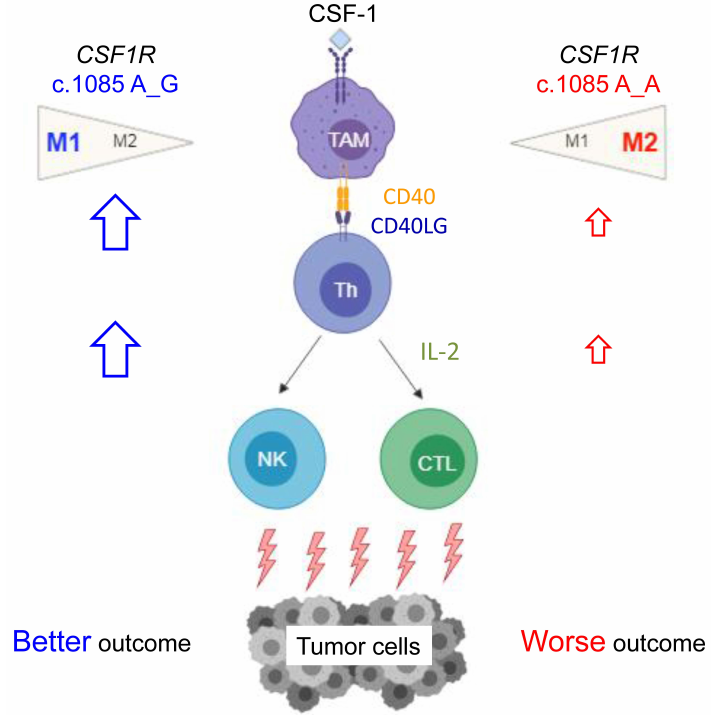
Figure 5. CSF1R c.1085 genotype regulated tumor immunity and affected clinical outcome. Macrophages with different CSF1R c.1085 genotypes responded to the stimulation of CSF-1 differen- tially. CSF-1 induced a prominent activation of CSF-1R, leading to an M2-like dominant polarization in macrophages with CSF1R c.1085 genotype A_A. CRC patients with CSF1R c.1085 genotype A_A had worse clinical outcome, including shorter disease-free survival and overall survival. In addition to the more M2-like macrophages, lower IL-2 expression generated by the interaction of CD40 ligand and CD40 between helper T cells and macrophages with CSF1R c.1085 genotype A_A also provide a mechanism explaining why CRC patients without this germline variant had a worse clinical out- come. TAM, tumor-associated macrophage; Th, T helper cell; NK, nature killer cell; CTL, cytotoxic T